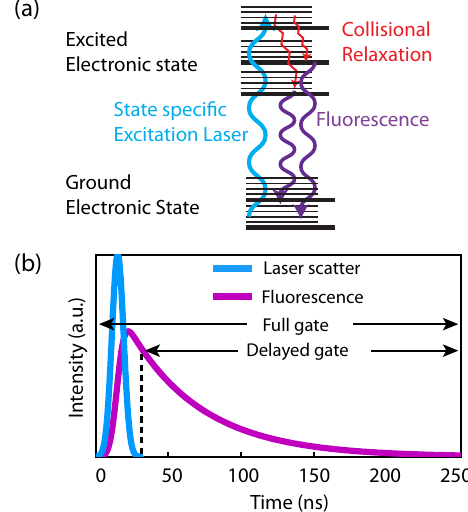
Figure 1. The spectral (a) and temporal (b) features of laser induced fluorescence detection. In (a) the laser excites a single rotational transition at 353.16nm. The fluorescence occurs after collisional relaxation and appears at longer wavelengths. In (b) time gating of fluorescence detection provides additional discrimination between prompt and longer timescale processes. Laser excitation and elas- tic scattering processes that include Raman, Rayleigh, and chamber reflections have timescales that match the laser pulse (25ns full- width). Fluorescence has a lifetime of tens of nanoseconds and the signal extends for more than 100ns beyond the end of the laser pulse and elastic scattering. The delayed gate captures HCHO fluores- cence while the full gate captures both fluorescence and scattered